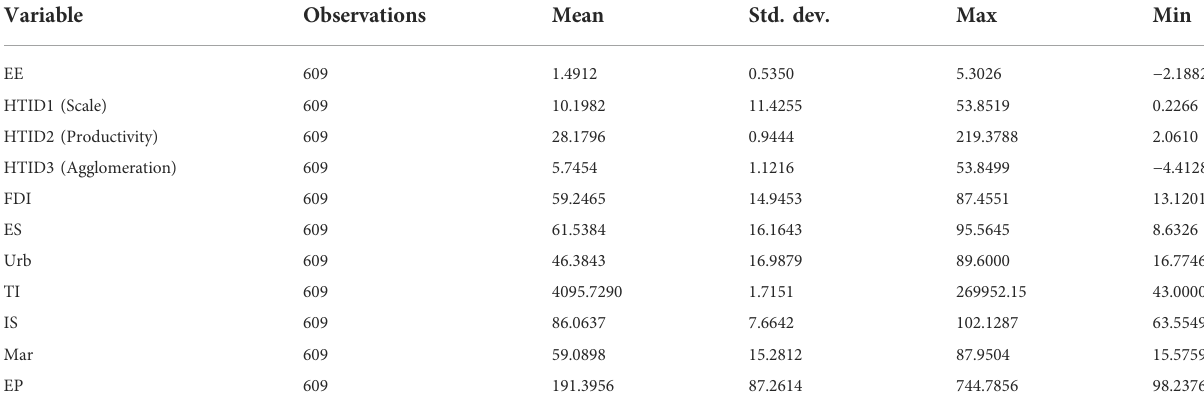
TABLE 2 Statistical description of variables.